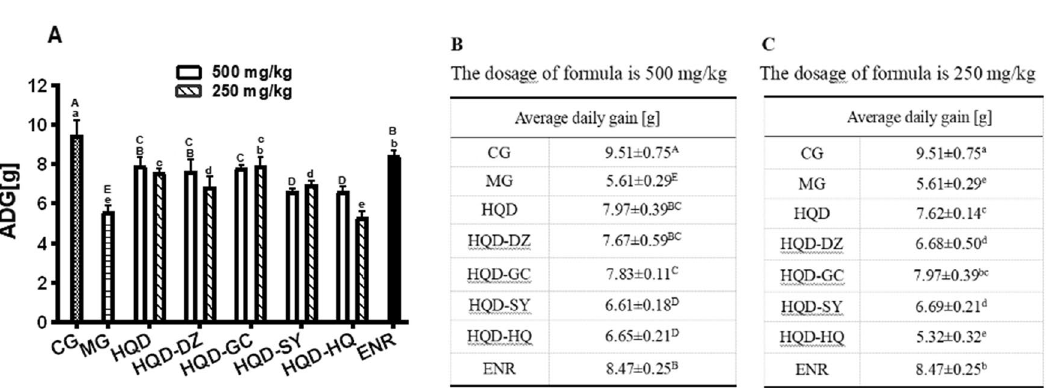
Figure 2. Mortality of chicks were represented in ( A – C ). The different letter superscript in the same column indicates that the difference is significant ( p < 0.05). CG, Control group; MG, Model group; DZ, jujube, Ziziphus jujuba ; HQ, Chinese skullcap, Scutellaria baicalensis ; GC, licorice, Glycyrrhiza glabra ; SY, white peony root, Paeoniae radix alba ; HQD, decoction consists of DZ, HQ, GC and SY; HQD-DZ, HQD absent of DZ; HQD-GC, HQD absent of GC; HQD-SY, HQD absent of SY; HQD-HQ, HQD absent of HQ; ENR, 10 mg/kg Enrofloxacin.